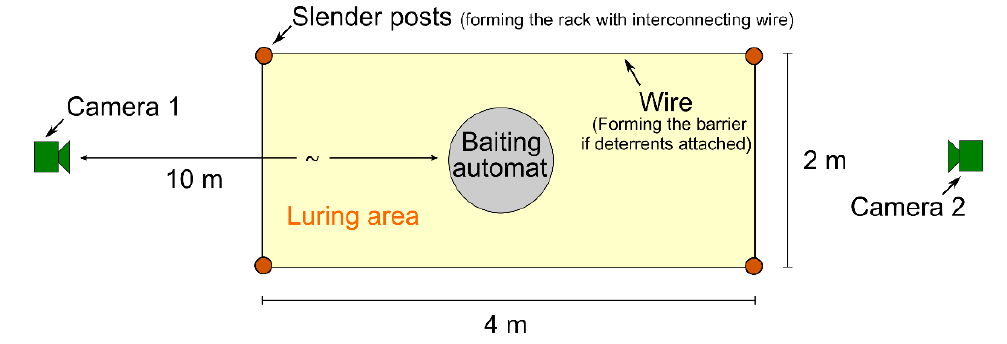
Figure 2. Standardized setup of the study sites.